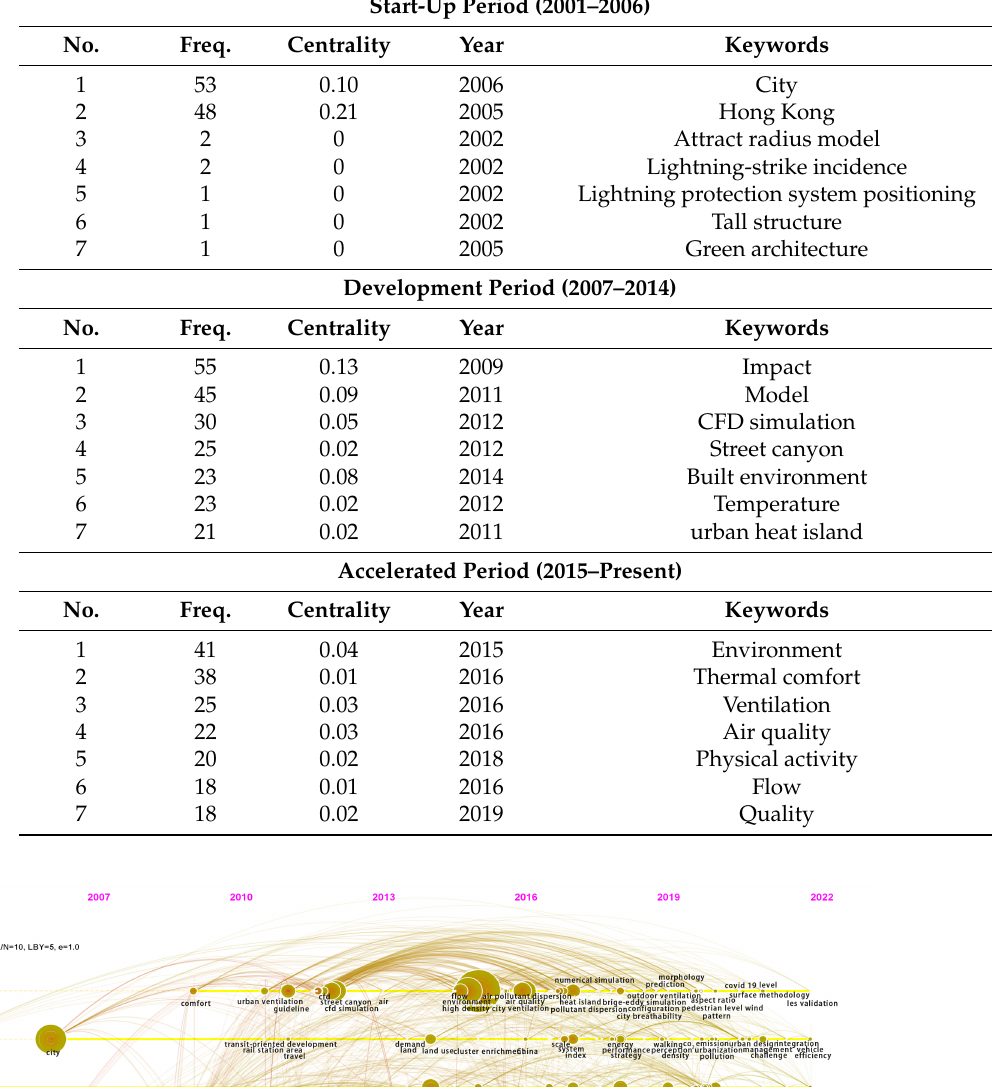
Table 9. The top seven high-frequency keywords in each period from 2001 to 2022.